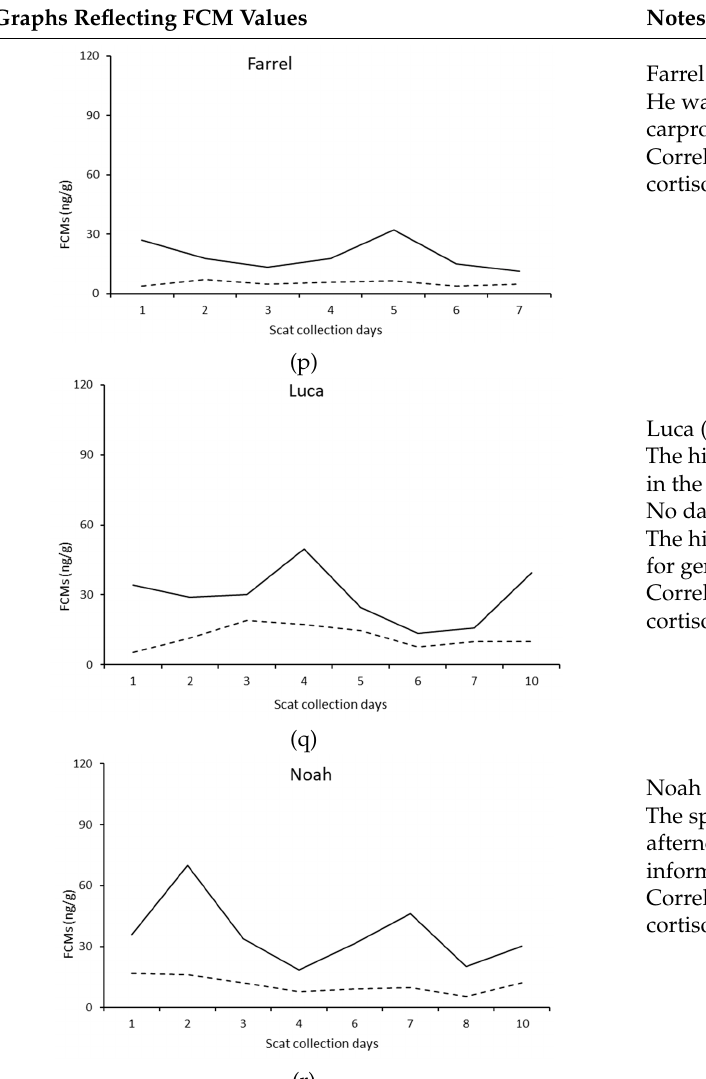
Table A3. Koalas whose second scat sample was collected after the administration of GCs (gluco- corticoids) was terminated.